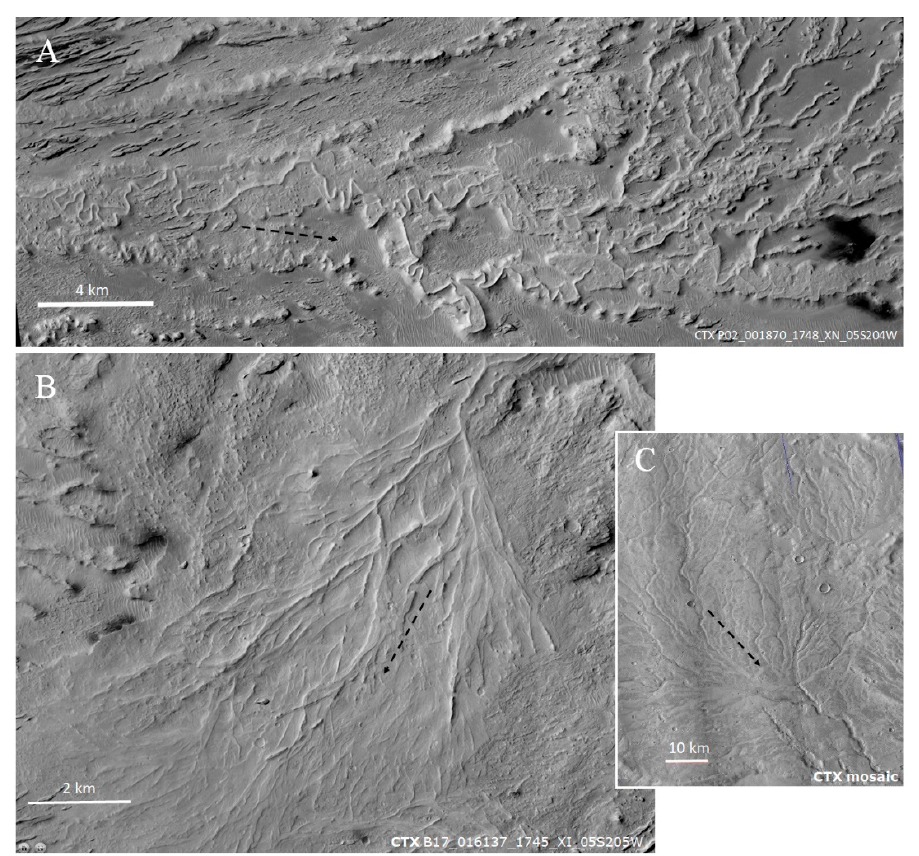
Figure 7. ( A ) Example of an inverted river channel on Mars located at 348.6 E, 7.7 N, approximately 130 km NNW from the rim of Crommelin crater due to water precipitation and runoff. The direction of flow indicated with an arrow points from the area of multiple “branches” to the “stem”. ( B ) An example of a “complex” inverted delta fan on Mars located in the area between the Asau and Kalba craters (930 km east of the Gale crater) in Aeolis Mensae, indicating a delta deposition and flow direction from the “stem” to “branches”. ( C ) Warrego Valles, a dendritic river network system indicating surface runoff due to precipitation over a large area. CTX images. The descending gradient is indicated with a dashed arrow in each